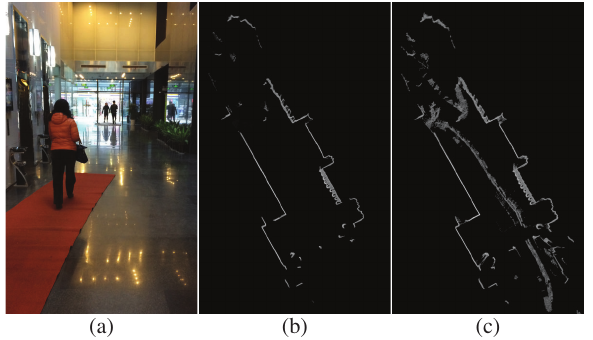
Figure 8: Comparative results of different likelihood updating strategies in an office lobby with multiple walking pedestrians: (a) a scene photo; (b)-(c) the last likelihood maps with our proposed learning strategy with decreasing and without it, respectively. Brighter intensities indicate higher likelihood